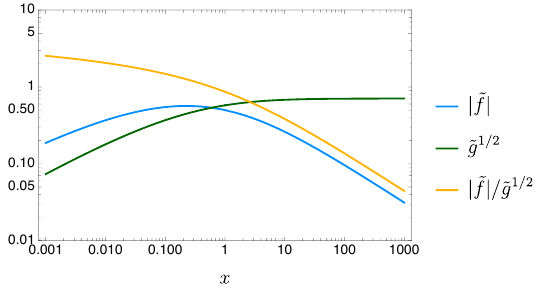
˜ f | , ˜ g and their ratio |